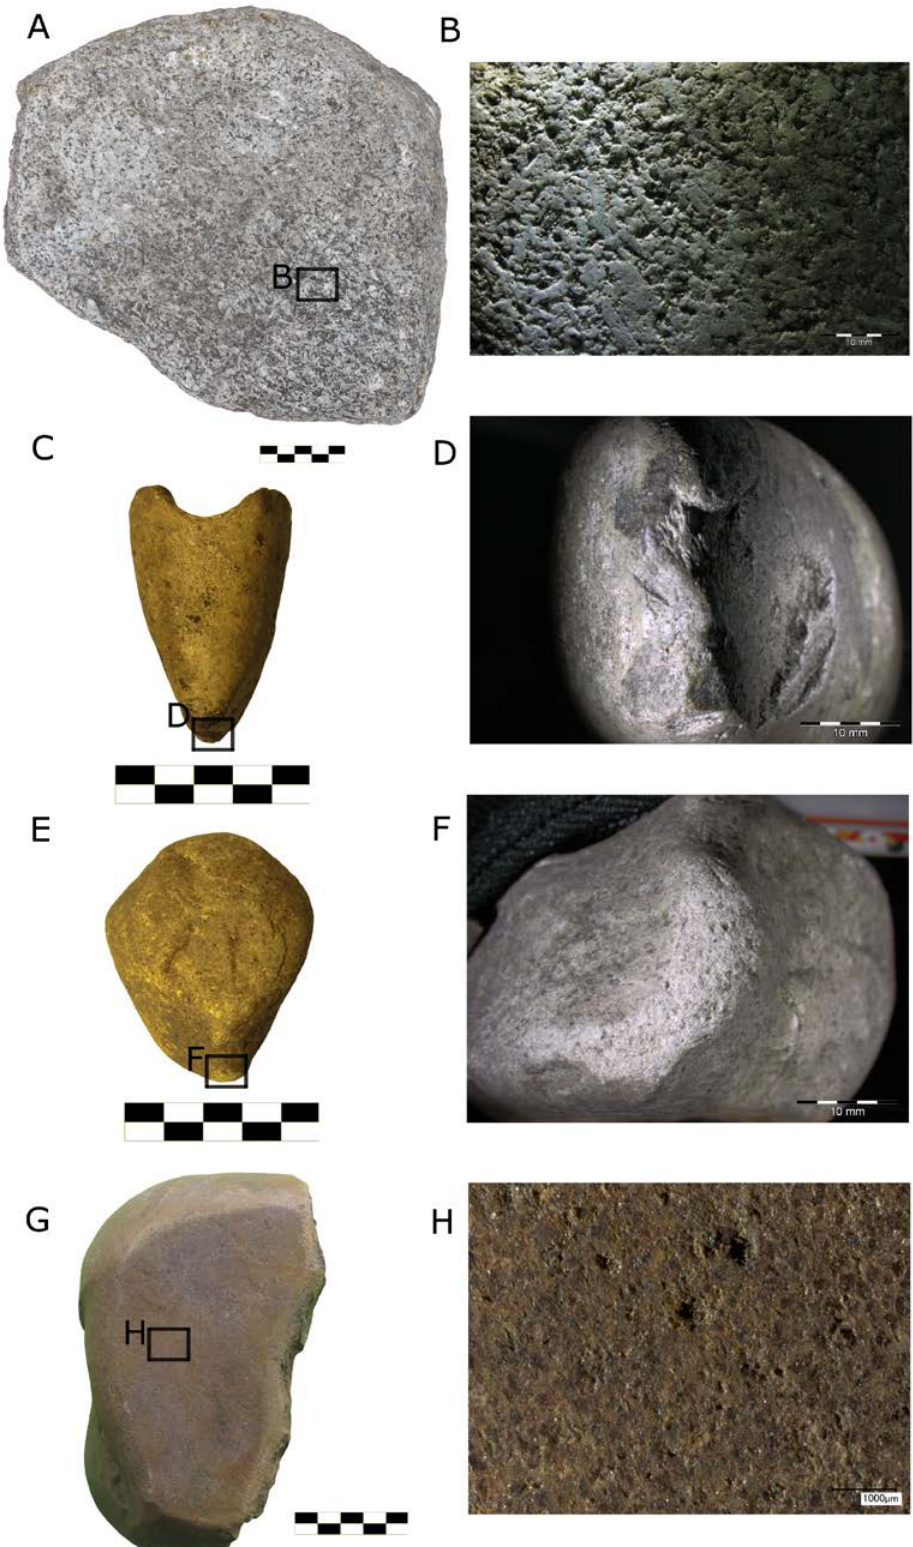
Figure 7. Selection of macro-lithic artefacts recovered in Early Bronze Age layers from Bruszczewo. A-B) Fragment of a grindingslab with intensive levelling on the active surface and intact anfractuosities in between. C- D) Shaft-hole axe showing a totally damaged bevel covered by stepped fractures. E-F) Percussor with a facet located on the bottom edge of the pebble and affected by pecking. G-H) Anvil showing a totally flat and shiny forging surface prepared previously to use through smoothing and rounding of edges in the